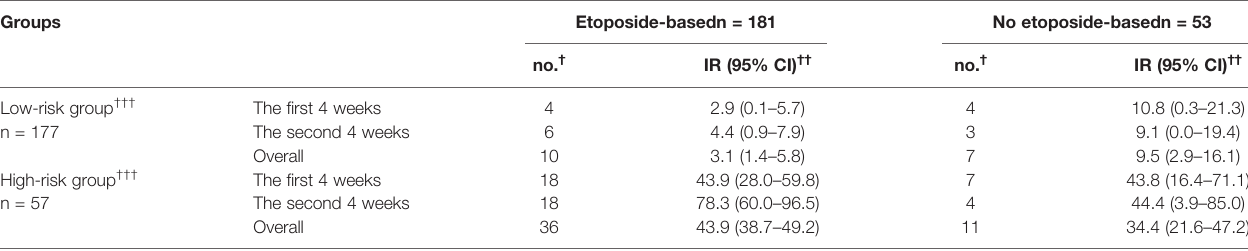
TABLE 4 | The incident rate of death in patients receiving different therapy strategy.